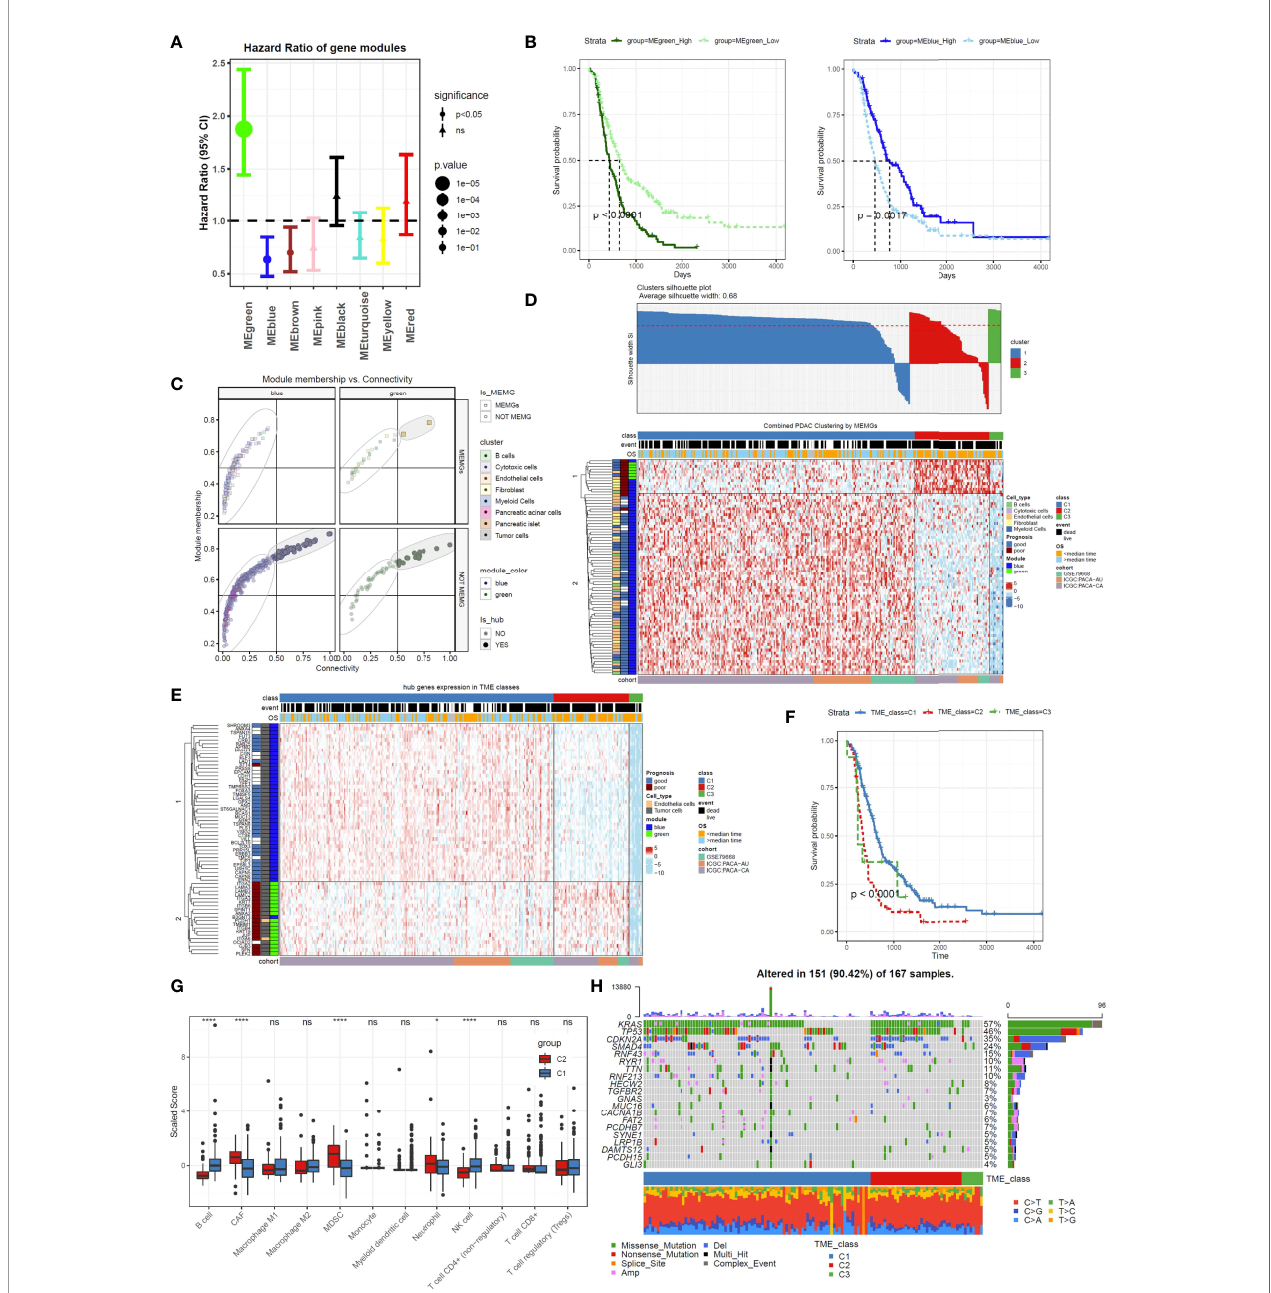
FIGURE 2 | Tumor microenvironment marker genes (MEMGs) stratify PDAC patients into subtypes with distinct outcomes. (A) The eigengene (ME) values for the gene modules were calculated in PDAC samples using the transcriptome data; then, the Cox regression analyses were performed to estimate the hazard ratio (HR). Forest plot shows the HR and and 95% con fi dence interval (95% CI). The optimal cutoff value in each module was estimated by the maxstat function. (B) Kaplan – Meier curves indicate that the eigengene values of green and blue modules are correlated with poor and favorite prognosis, respectively, P-values were evaluated by a log-rank tests. (C) MEMGs and hub genes in the prognosis-related modules (blue and green modules) were de fi ned by the expression in cell components, module membership, and intramodular connectivity. (D) MEMGs stratify PDAC patients into three TME classes by a consensus cluster algorithm. Different expressed MEMGs among subclasses were shown by a heatmap. (E) The heatmap shows the expression pattern of hub genes in different TME classes. (F) Kaplan – Meier curves show the variations of survival rates among TME classes. Statistical analysis was taken by the log-rank test. (G) Relative abundance and differentiations of tumor environmental cells in two major TME classes. The abundance of these cells was estimated by the quanTIseq algorithm or tumor immune dysfunction and exclusion (TIDE) methods. Differences were tested by Student ’ s t-test, ****P < 0.0001, *P < 0.05, ns: not signi fi cant. (H) The water fl ow plot displays recurrent genetic variations in each TME